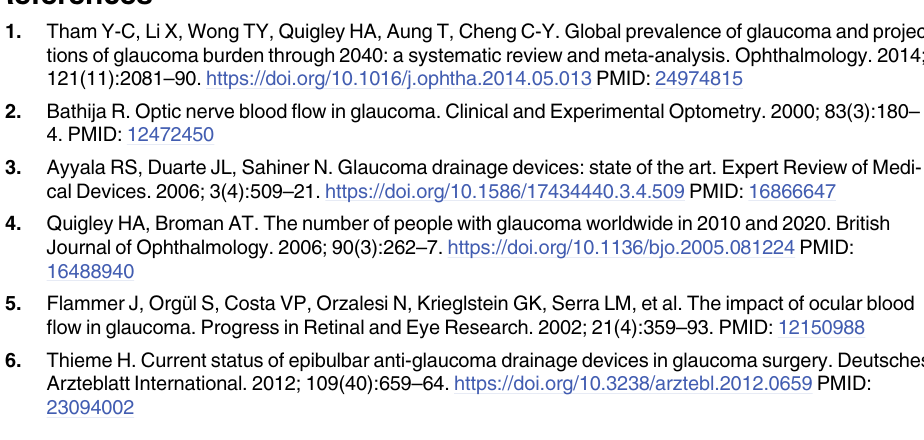
S1 Table. Individual IOP of both eyes in groups A and